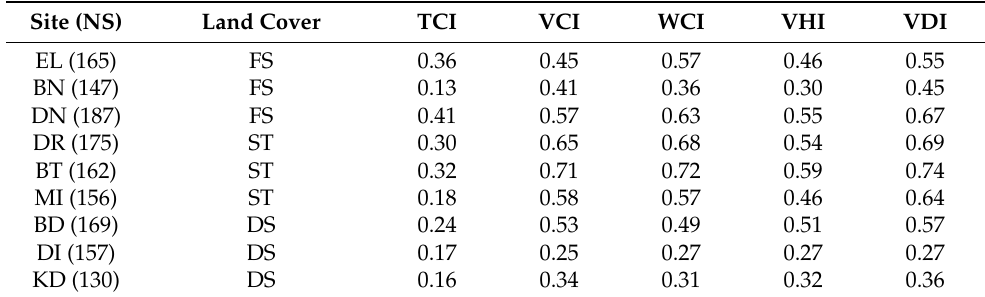
Table 3. The R values between drought indices and NFB for the period 2000–2015. NS: number of samples at 0.01 confidence